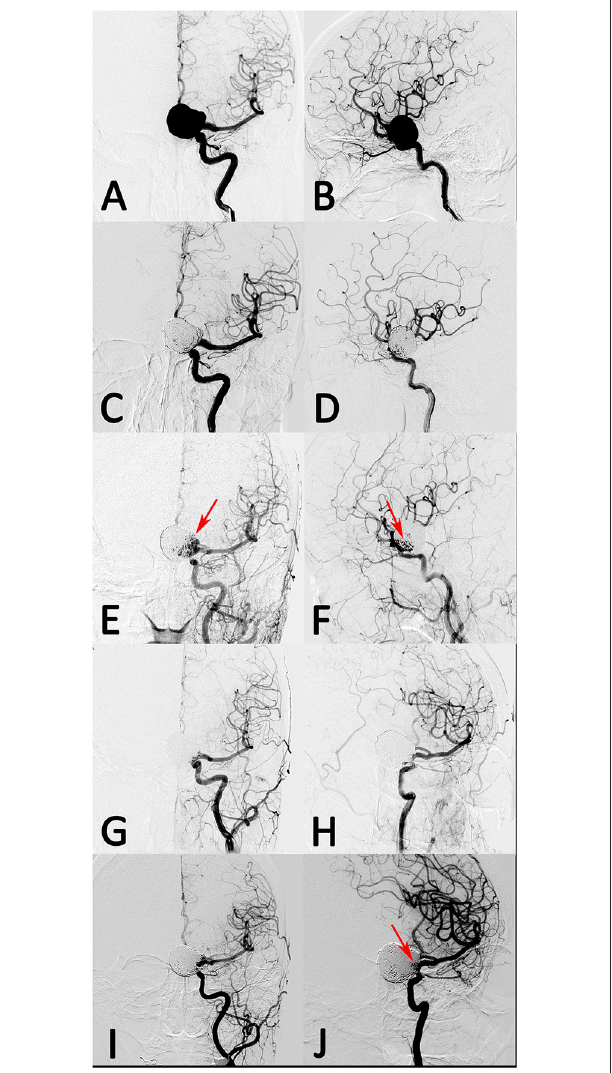
FIGURE 2 | A patient with left giant posterior communicating artery aneurysm was treated with stent-assisted coil embolization. (A,B) The aneurysm was occluded near-completely after treatment. (C,D) However, the aneurysm recanalized at 10 months follow-up. ( E,F , arrow) The recanalized aneurysm was retreated with stent-assisted coil embolization and had complete occlusion after treatment. (G,H) However, the aneurysm had re-recanalization at 8 months follow-up angiograph result ( I,J ,